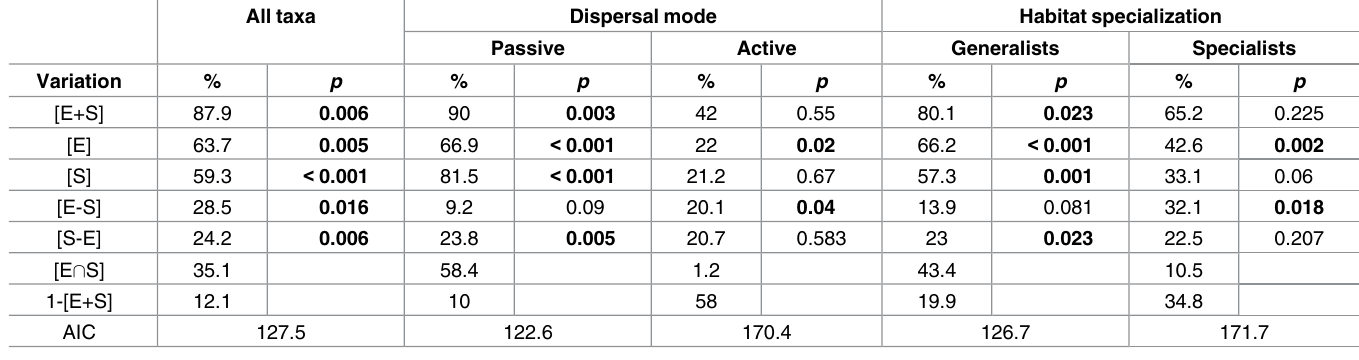
Table 2. Variation partitioning explained (%) among environmental and spatial variables, and associated p values (variables at p (cid:20) 0.05 in bold) of the invertebrate data matrix for all the taxa, dispersal mode, and habitat specialization at the beach sites located around Hanko Peninsula (Baltic Sea, Finland). [E+S] = total explainedvariation by all variablesin the model, [E] = variation explainedby environmental variables, [S] = variationexplained by spatial variables, [E-S] = pure environmental variation, [S-E] = pure spatial variation, [E \ S] = variationsharedby environmental and spatial variables and 1-[E +S] = unexplained